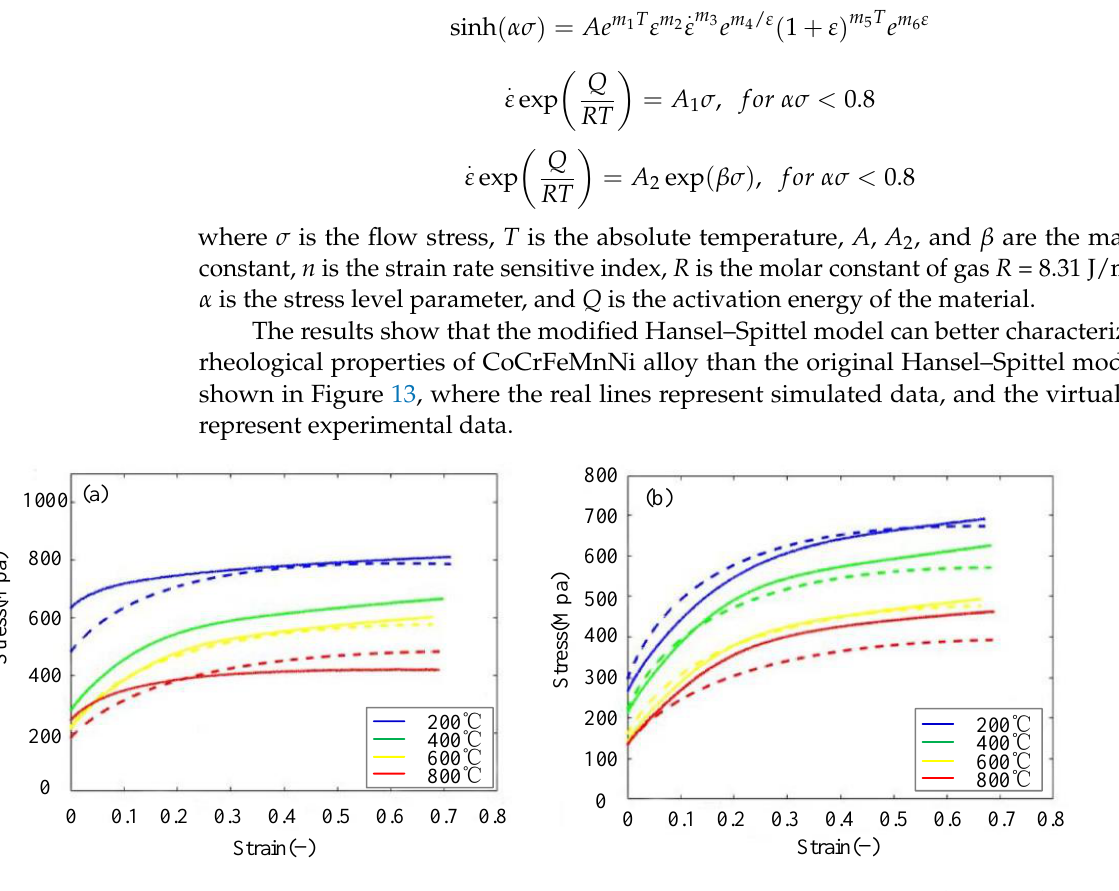
Figure 13. The rheological properties of CoCrFeMnNi alloy [28], ( a ) 0.01 s −1 ; ( b ) 1 s −1 .